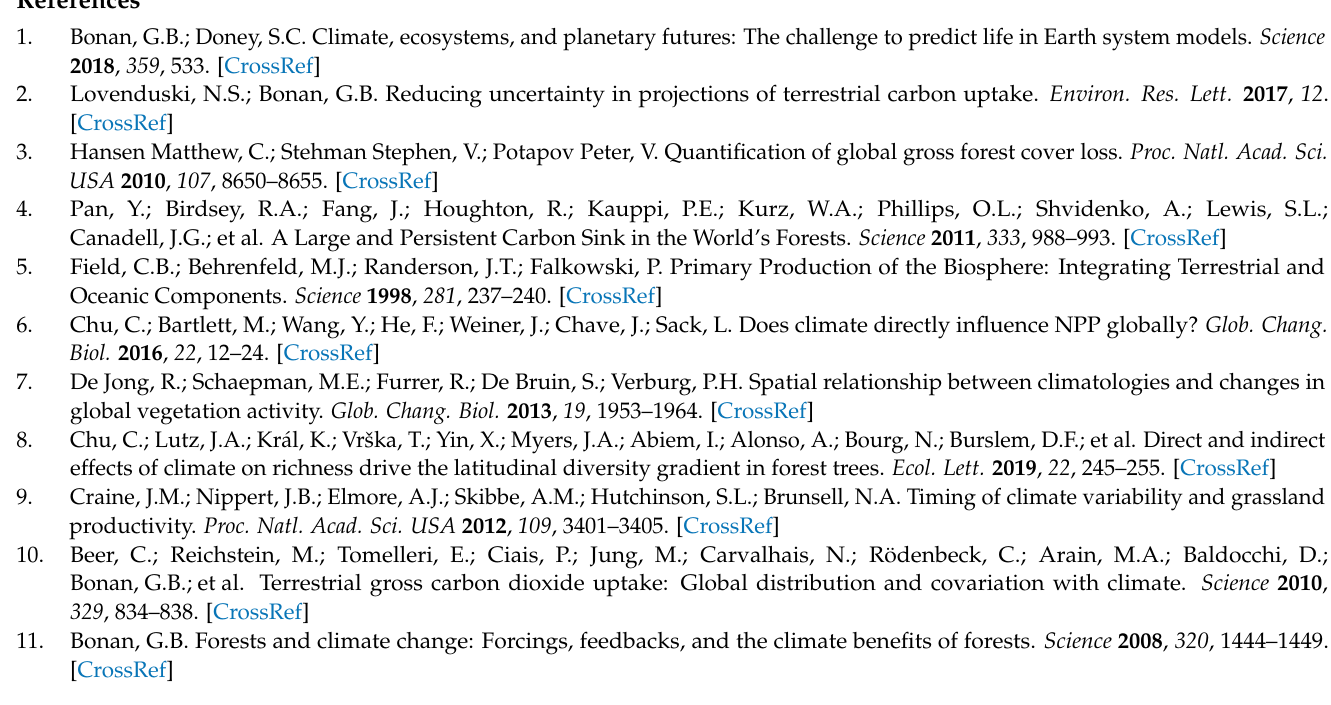
Figure A2. Spatial distribution of values for each 0.05 ◦ × 0.05 ◦ sample of ( a ) TS, ( b ) SR, ( c ) SM200, ( d ) VPD, ( e ) SM10, ( f ) WS, ( g ) P, ( h ) CO 2 , ( i ) TP, ( j ) CLAY, and ( k ) TN.